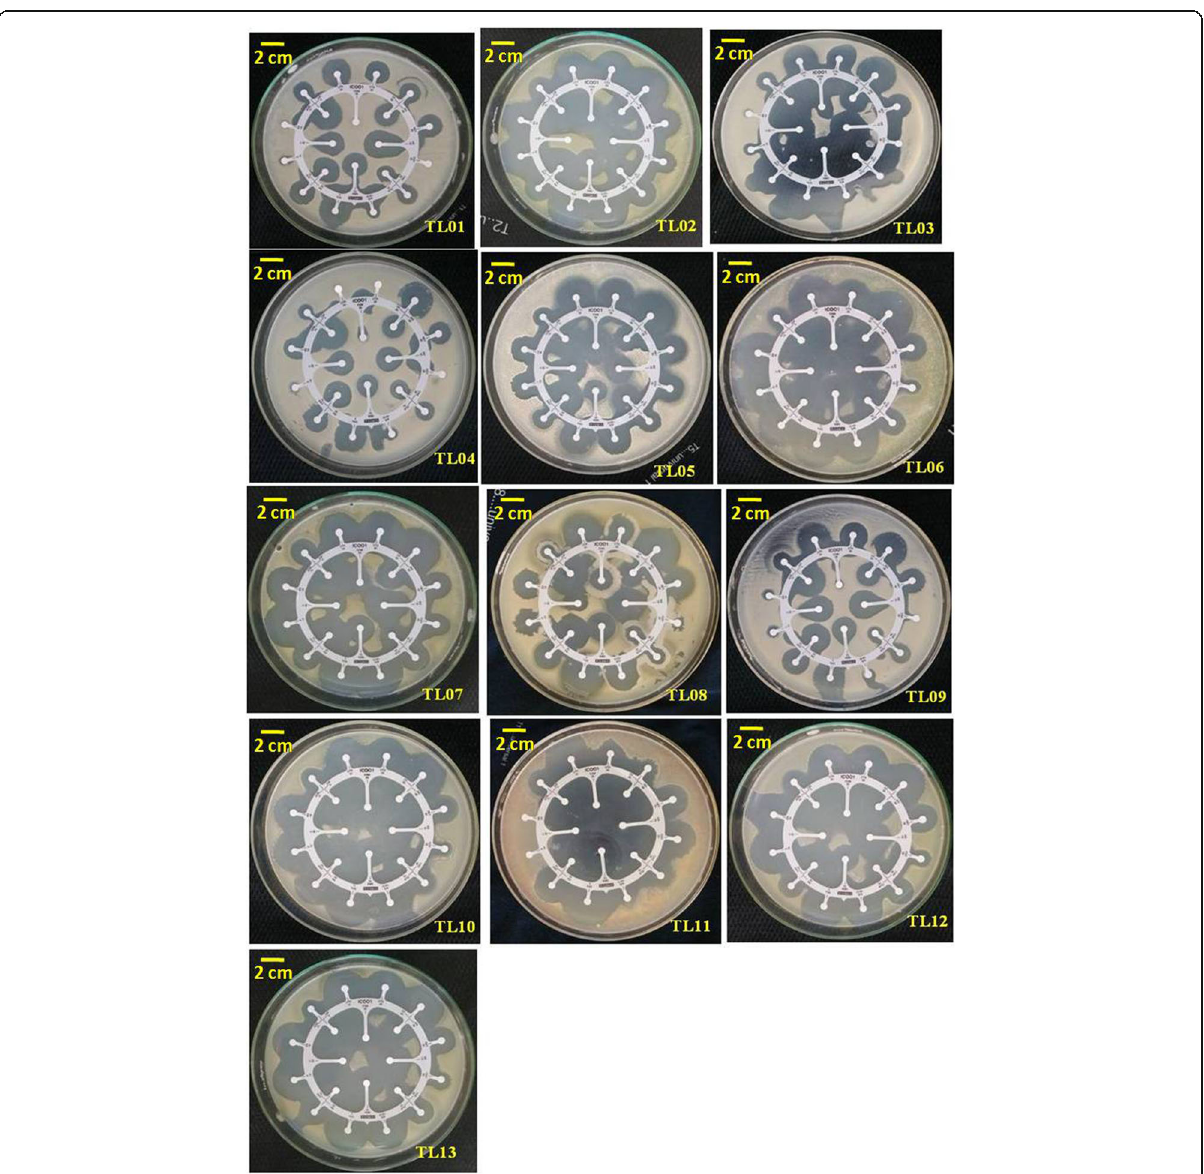
Fig. 2 Antibiotic assay of bacteria isolated from treated